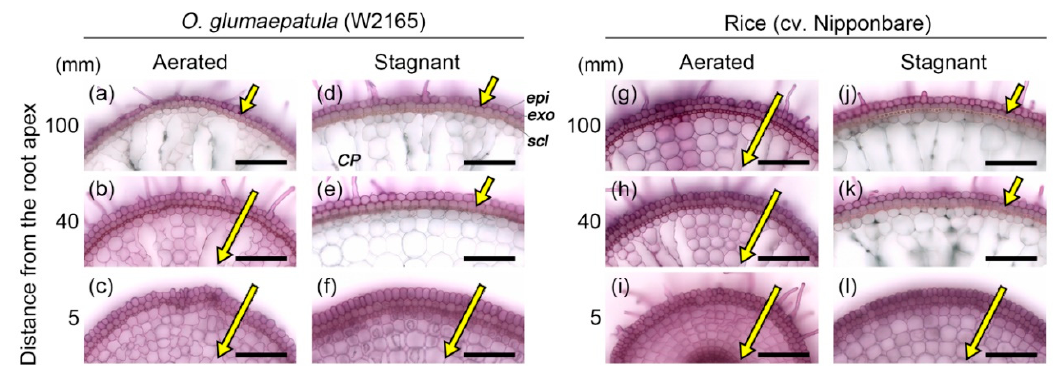
Figure 4. Permeability of the outer part of roots to an apoplastic tracer (periodic acid) in accession W2165 of O. glumaepatula and rice (cv. Nipponbare) under aerated or stagnant conditions. The permeability of the exodermis was evaluated at the basal parts (95–105 mm from the root apex; ( a , d , g , j ), middle parts (35–45 mm from the root apex; ( b , e , h , k ) and root tips (2.5–7.5 mm from the root apex; ( c , f , i , l ) of adventitious roots of 115–120 mm length. Purple color indicates that periodic acid penetrated into root tissues. The length of yellow arrows indicates the extent of penetration. Plants were grown in aerated nutrient solution for eight days and then transferred to deoxygenated stagnant 0.1% agar solution or continued aerated solution for 13–15 days. CP , cortical parenchyma; epi , epidermis; exo , exodermis; scl , sclerenchyma. Scale bars: 100 μ m.